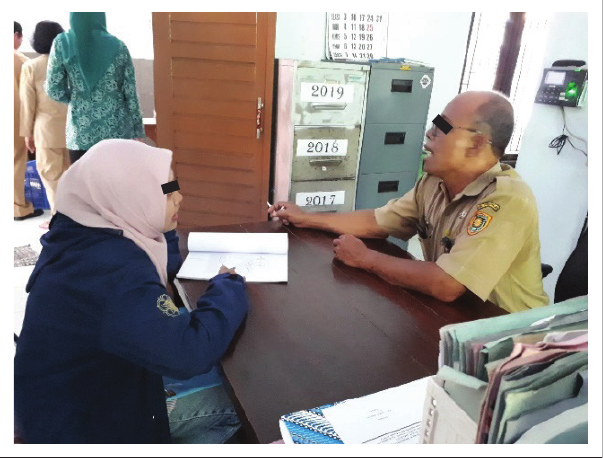
FIGURE 2: Confirmation with the head of planning, evaluation and general affairs of the Bagelen subdistrict regarding flood-prone